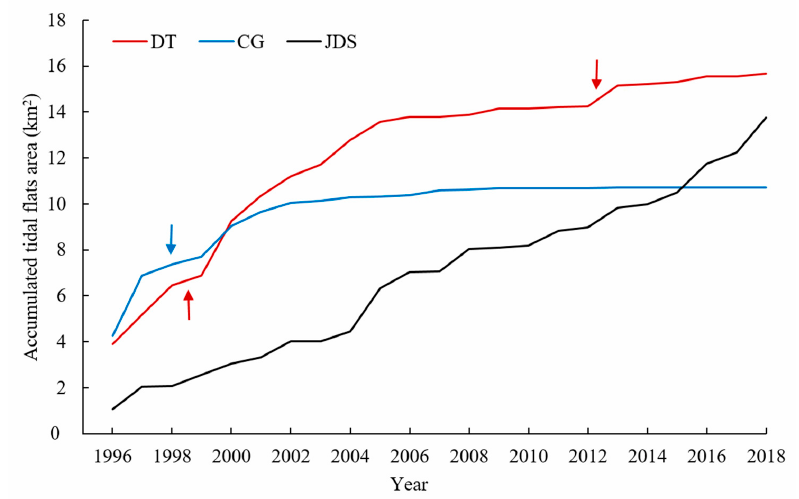
Figure 8. Accumulated tidal flats areas of three sample areas from 1996 to 2018.